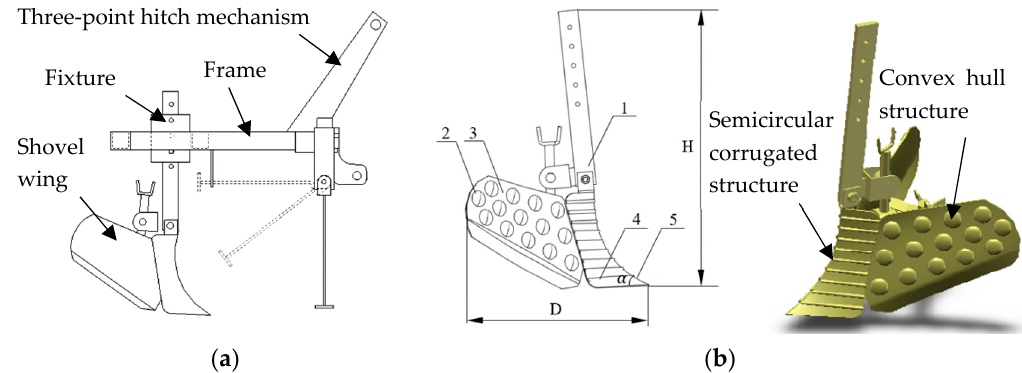
Figure 1. The soil cultivator and textured shovel wing structure. 1. Shovel handle; 2. convex hull; 3. wing plate; 4. semicircular corrugation; 5. shovel chest. ( a ) Soil cultivator; ( b ) Shovel wing with textured surface. H is the height of shovel wing, D is the width of shovel wing, α is the soil entry angle of shovel chest.